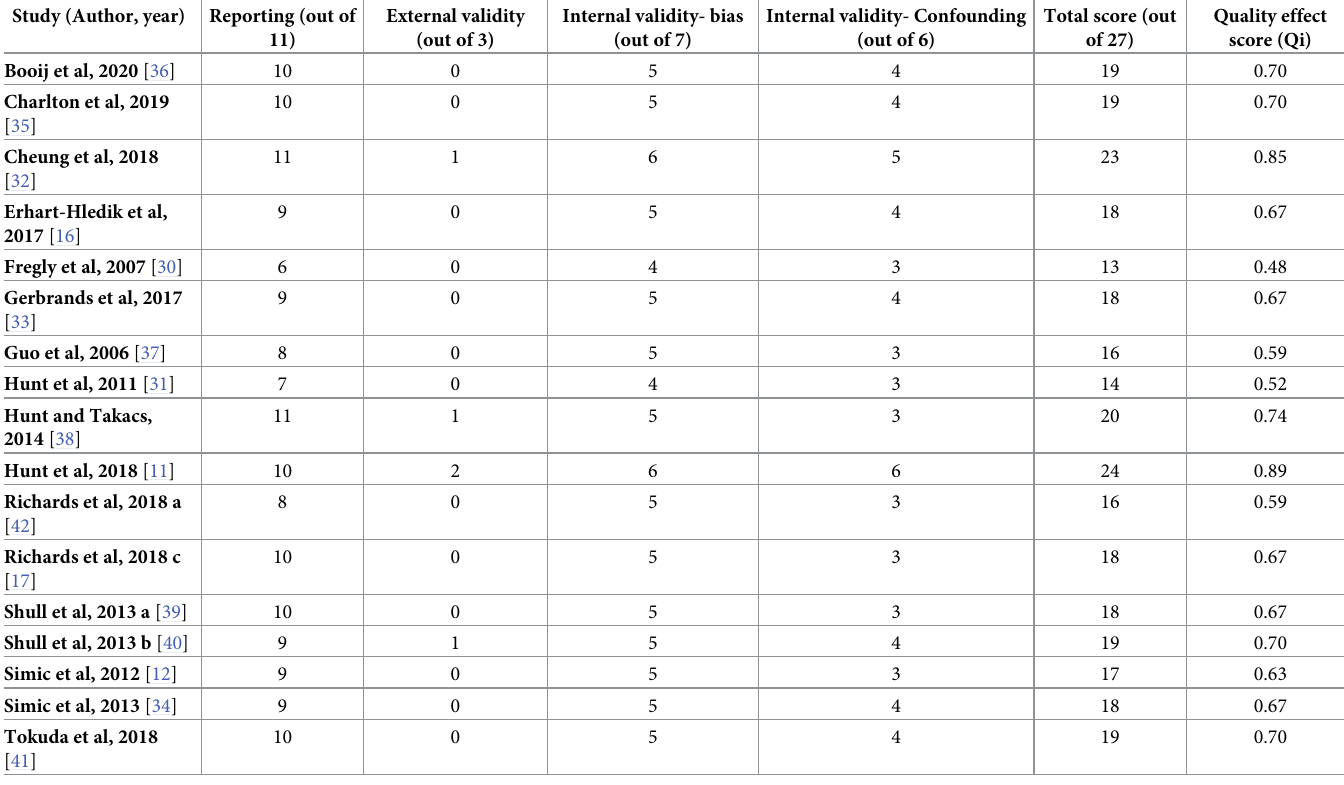
Table 2. Methodological quality of included studies assessed using Downs and Black scale